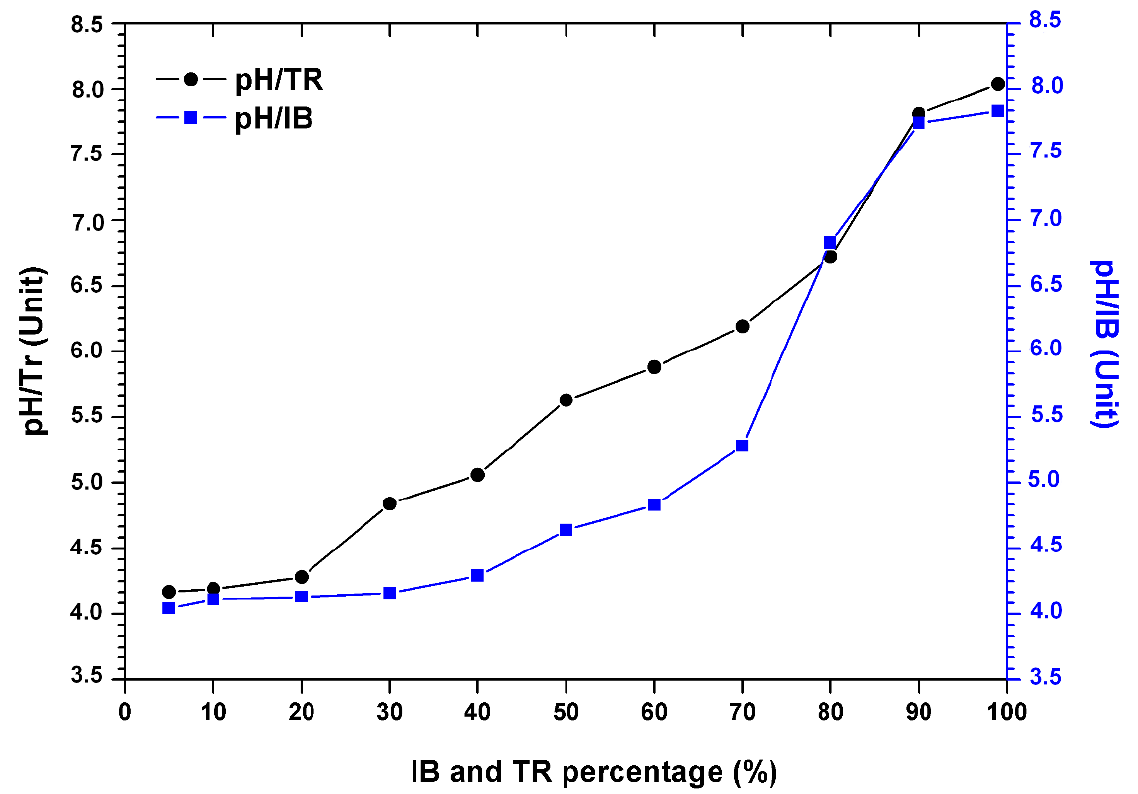
Figure 3. Evolution of the pH of the margin–bentonite mixtures.